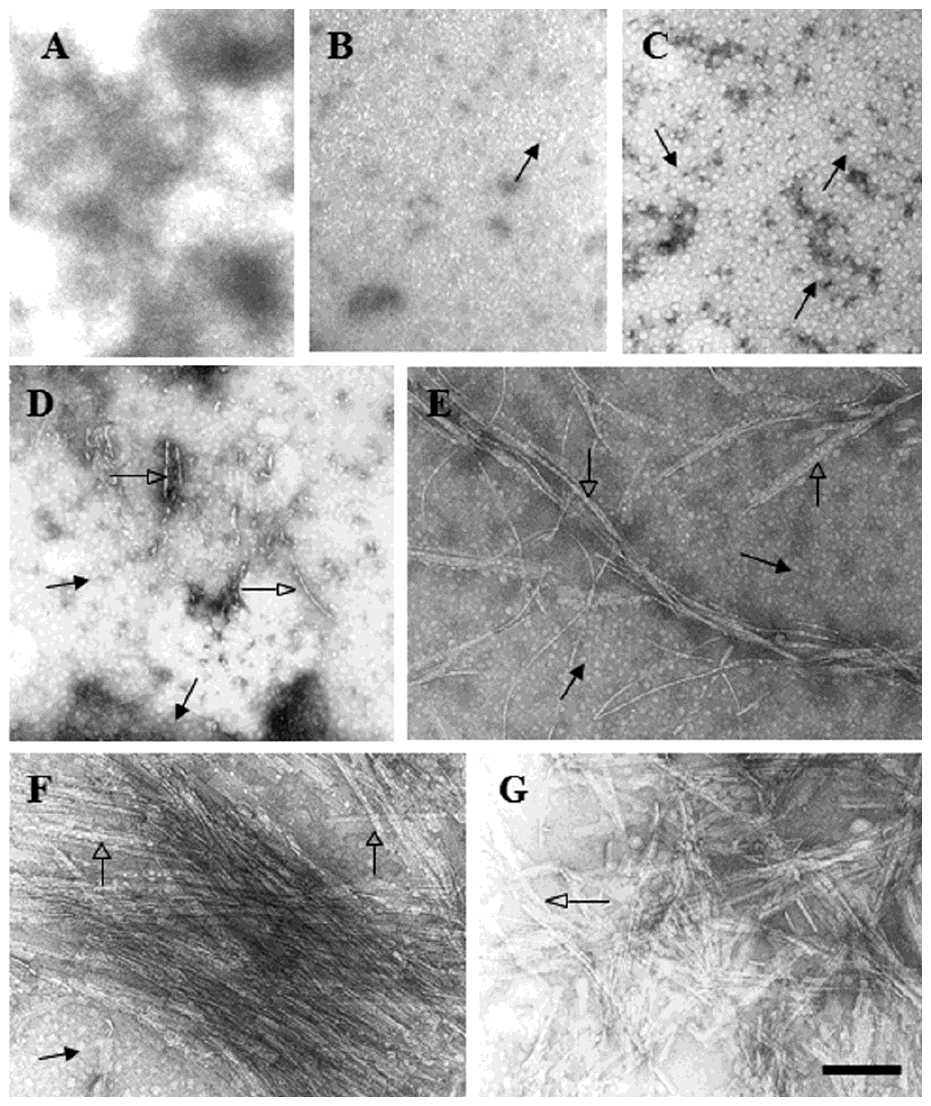
Figure 5. Ultrastructural analysis of peptides by transmission electron microscopy (TEM); ( A ) Helix- X at 48 h of incubation at 37°C; ( B ) Helix- Z at 0 h of incubation; ( C ) Helix- Z at 0.5 h of incubation; ( D ) Formation of helix- Z protofilaments at 1.0 h of incubation; ( E ) Helix- Z under constant agitation at 6.0 h of incubation; ( F ) Helix- Z under constant agitation and 48 h of incubation; ( G ) Helix- Z under constant agitation at 120 h of incubation. Solid arrows indicate oligomeric structures, open arrows show protofibrils and amyloid fibrils. The concentration of peptide used in all conditions was 60 µg/mL. Bar indicates 200